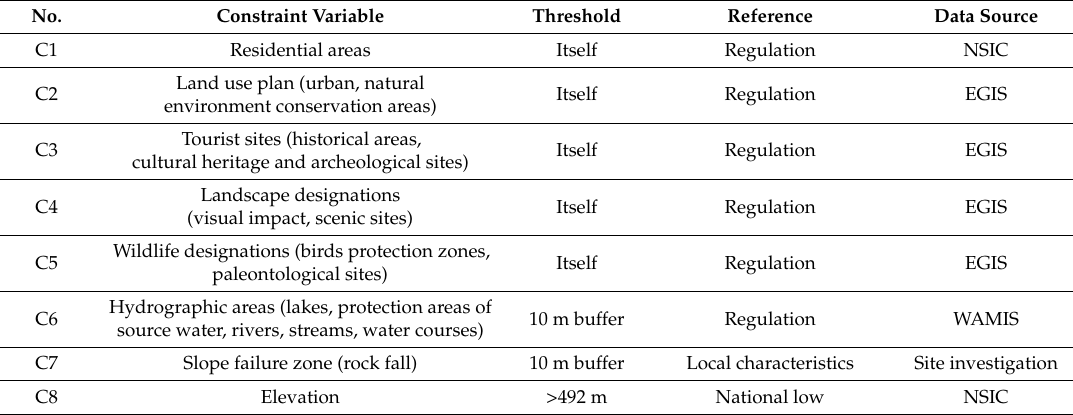
Table 2. List of constraint variables and their referential rationale, original data extension, and data source of the original data. NSIC: National Spatial Information Clearinghouse of Korea; EGIS: Environmental Geographic Information Service of Korea; and WAMIS: Water Management Information System of Korea.